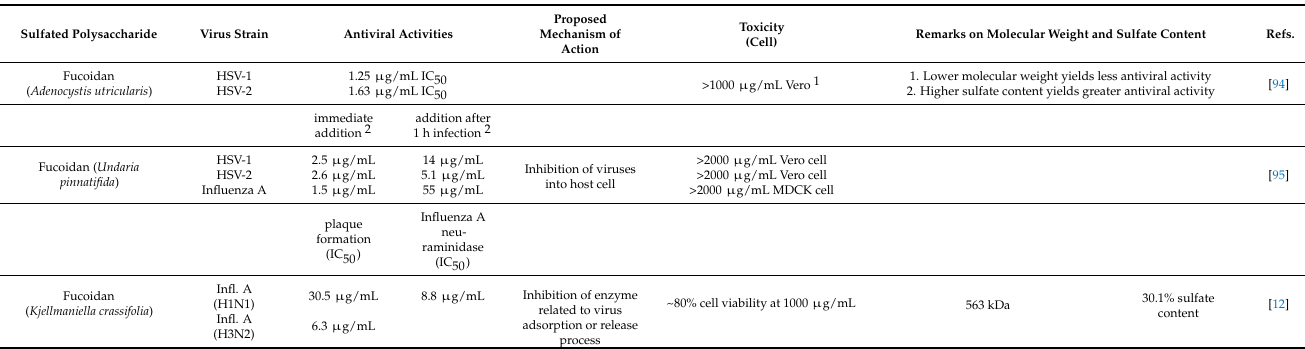
Table 4. Summary of antiviral activity among various fucoidan, with each respective proposed mechanism of action and remarks on molecular weight and sulfate content of the tested